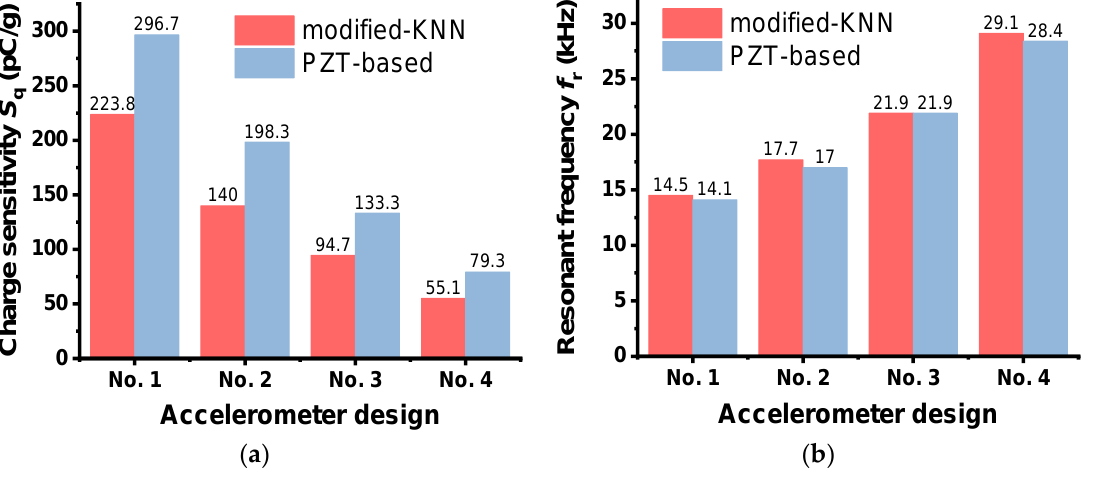
Figure 7. Comparison of ( a ) charge sensitivity S q and ( b ) resonant frequency f r of accelerometer prototypes made of KNN-BNKLZ-BS and PZT ceramics. Experimentally measured results for the PZT-based accelerometers were taken from ref. [36].